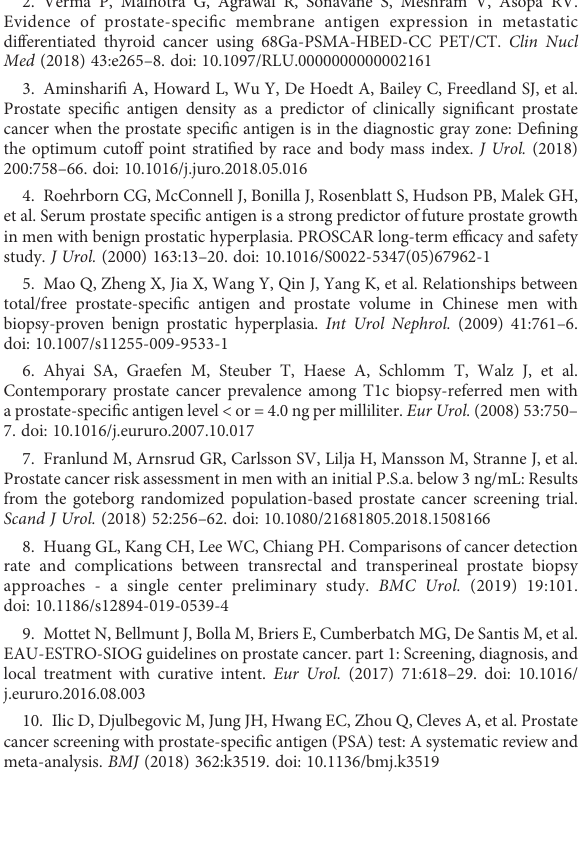
SUPPLEMENTARY TABLE 1 Clinical characteristics of patients in the external validation cohort. SUPPLEMENTARY TABLE 2 Raw data from the First Af fi liated Hospital of Guangxi Medical University, Guangxi, China. SUPPLEMENTARY TABLE 3 Validation database from Changhai Hospital, Naval Medical University, Shanghai,